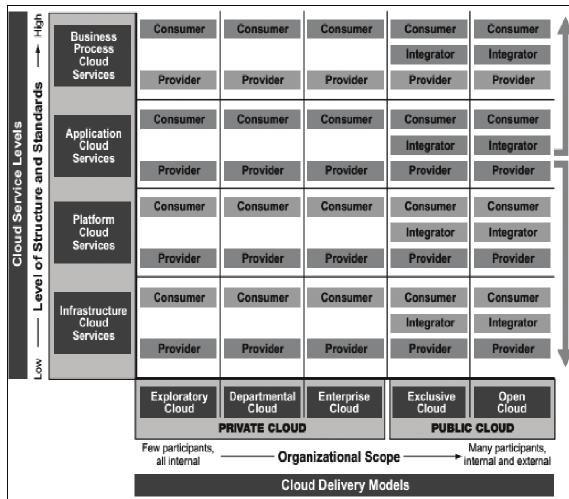
Fig.1. Cloud subtypes. (Source: 18)